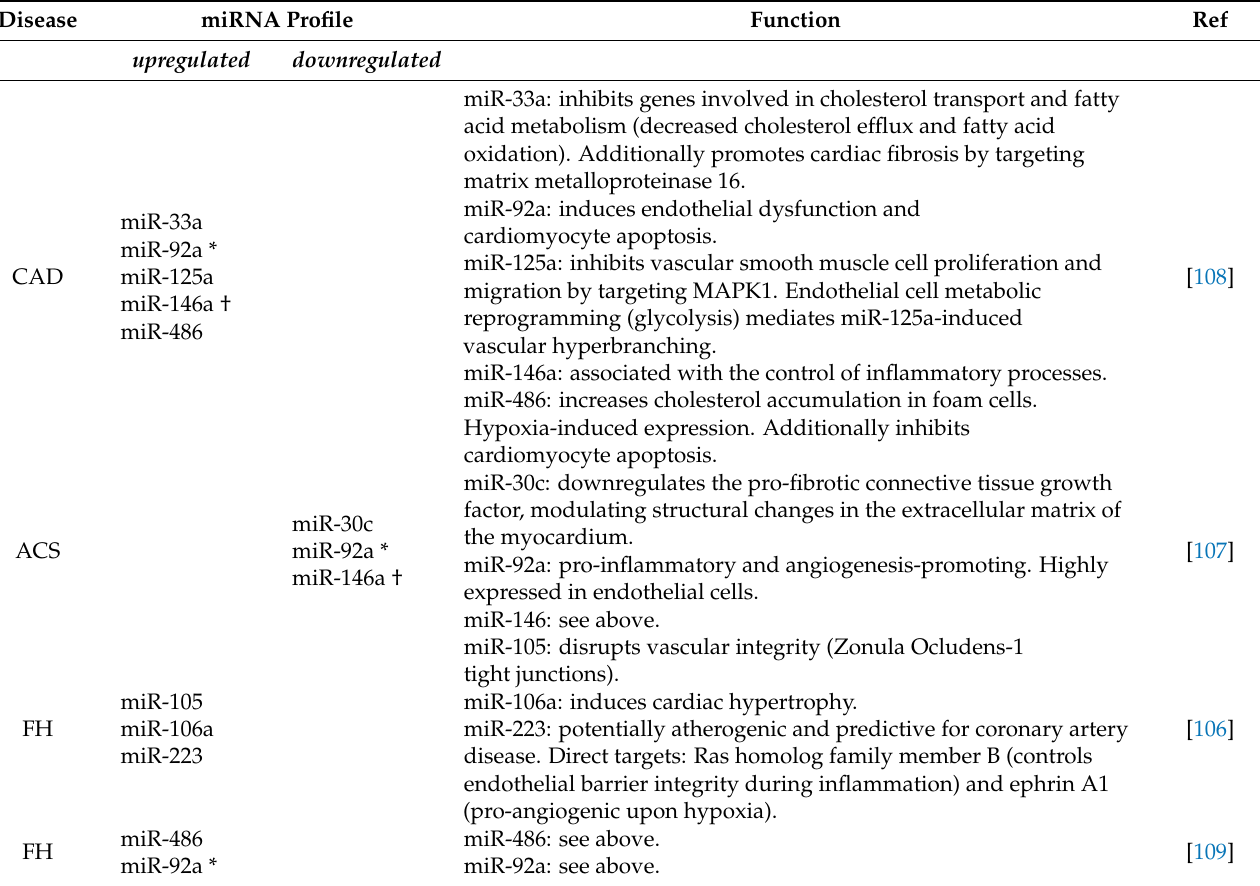
Table 1. CVD-associated miRNA profiles of